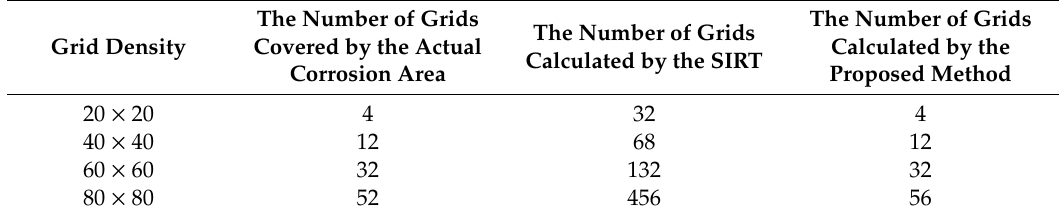
Figure 7. Tomographic reconstruction images for a 1.5 mm thick aluminum plate with a 20 mm diameter circular flat-bottomed hole with different grid density using the proposed method. The thickness loss was 50% within the flaw. ( a ) The number of grids was 20 × 20, ( b ) the number of grids was 40 × 40, ( c ) the number of grids was 60 × 60, and ( d ) the number of grids was 80 × 80. Table 1. With different grid density, the number of grids covered by the actual corrosion area were compared to ones calculated respectively by the SIRT and the proposed method.